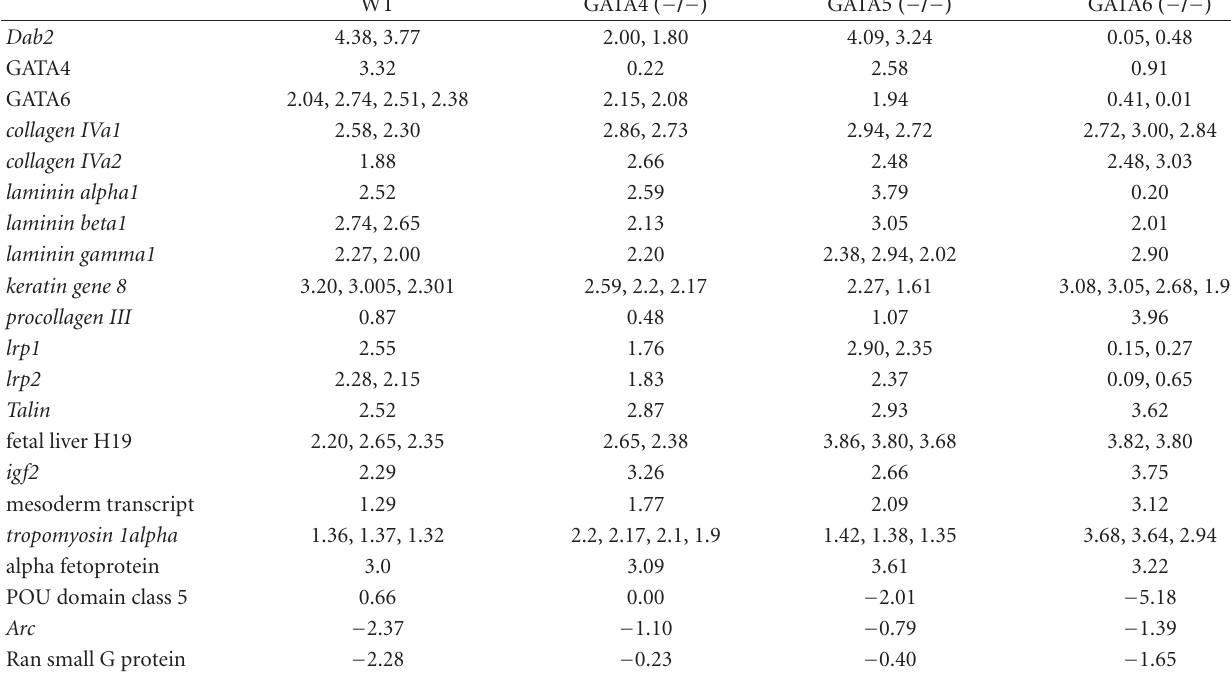
Table 2: Limited list of genes whose expression is significantly altered following retinoic acid treatment of ES cells grow in monolayer cultures. WT GATA4 ( − / −